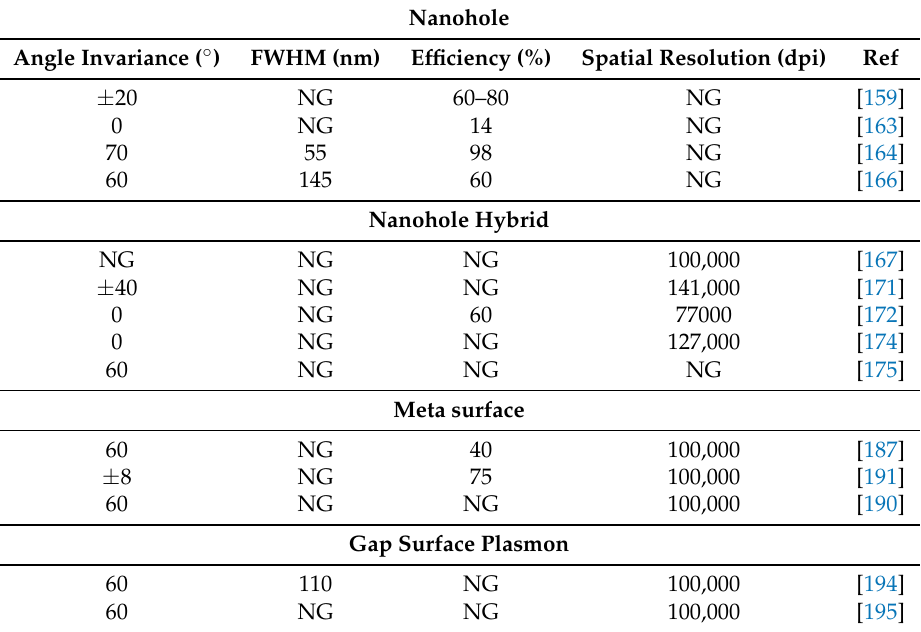
Table 3. LSPR-based color